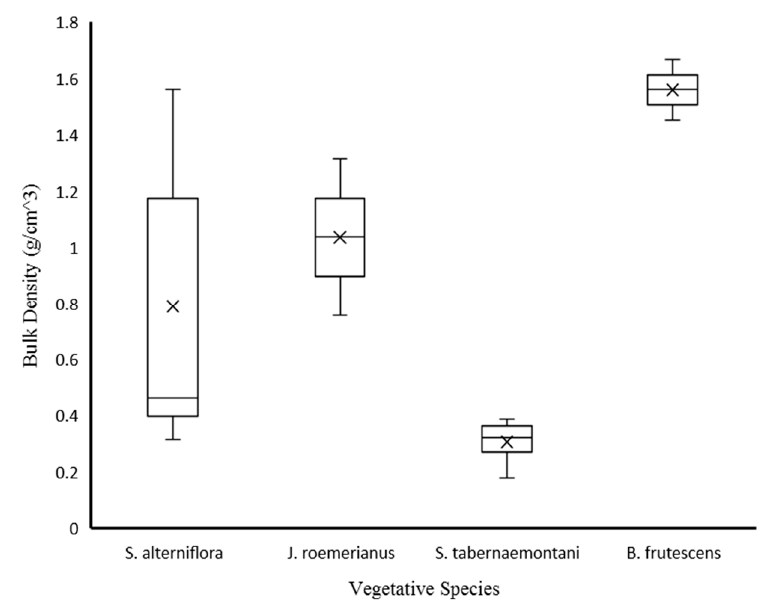
Figure 3. Bulk density values of four dominant in saltmarshes along the coast of Georgia (USA).